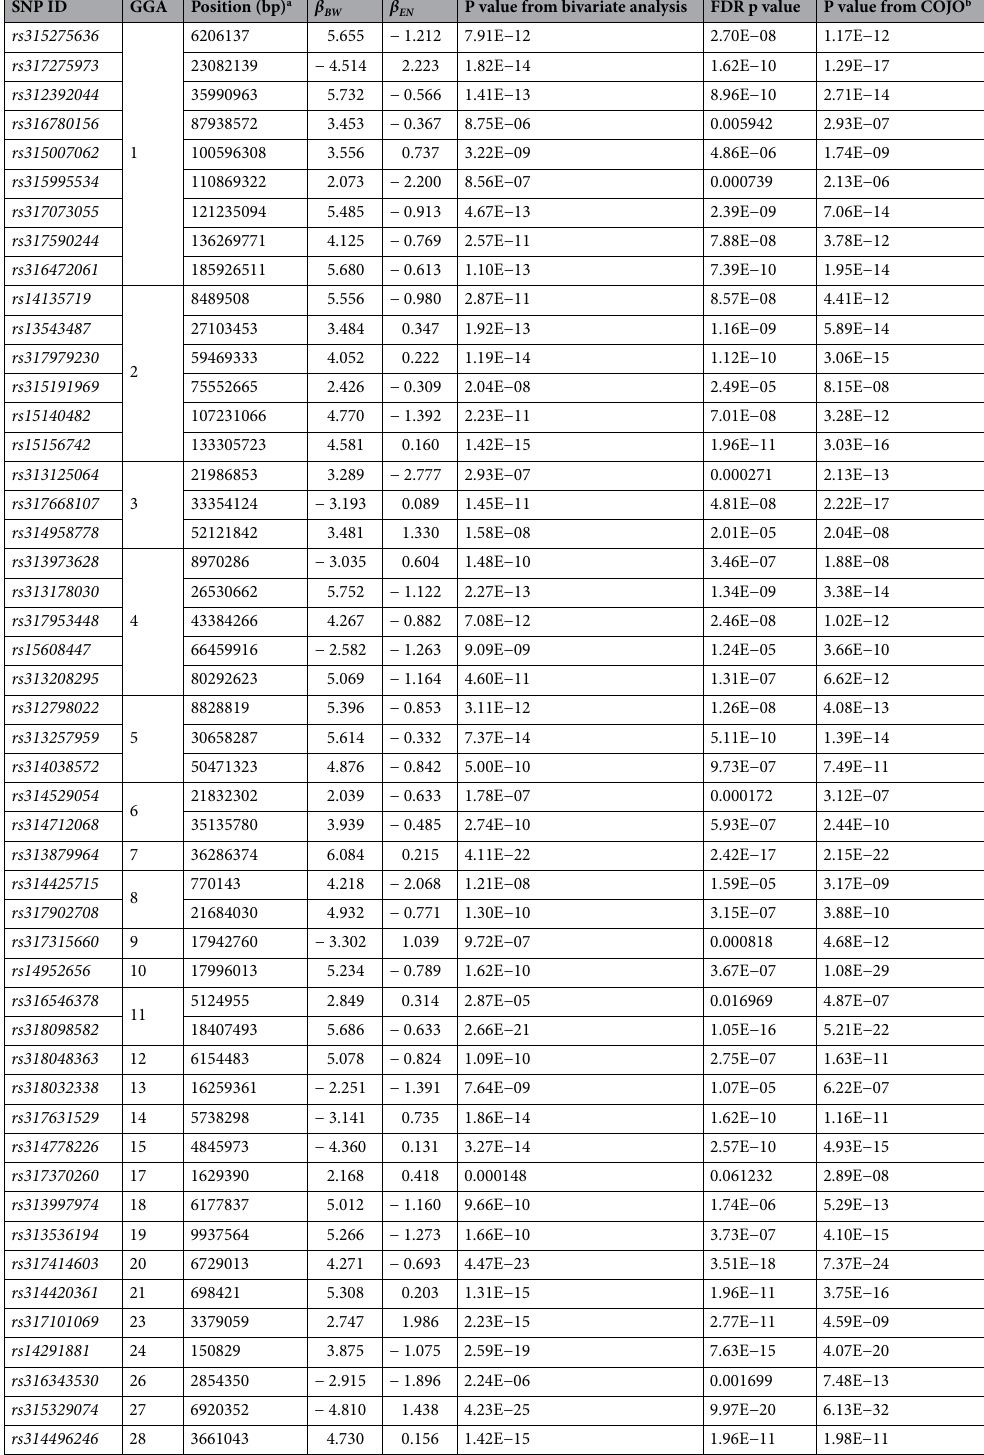
Table 1. Independent cross-phenotype (CP) significant SNPs for body weight and egg number in broilers.n The marker effect sizes ( β BW , β EN ) of CP-SNPs on the two traits are also provided. a Positions are based on GRCg6a assembly. b COJO stands for conditional and joint